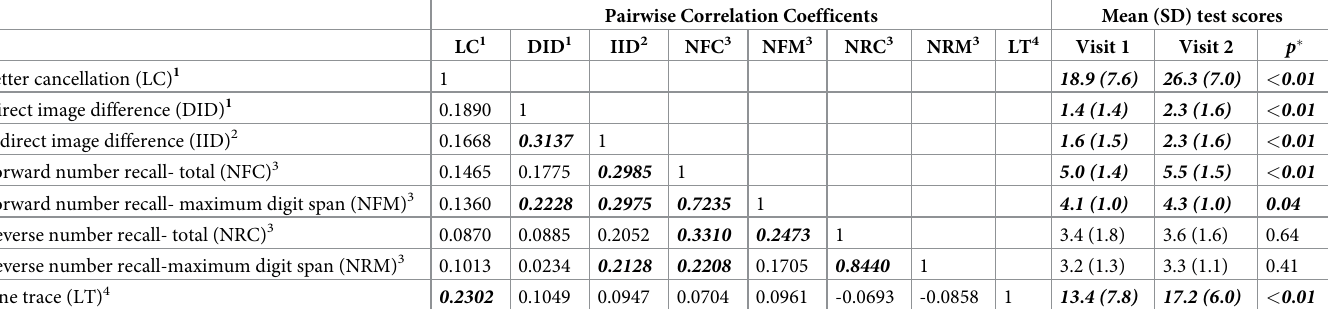
was significantly higher under the control condition sg and U were strongly correlated both in the sg col